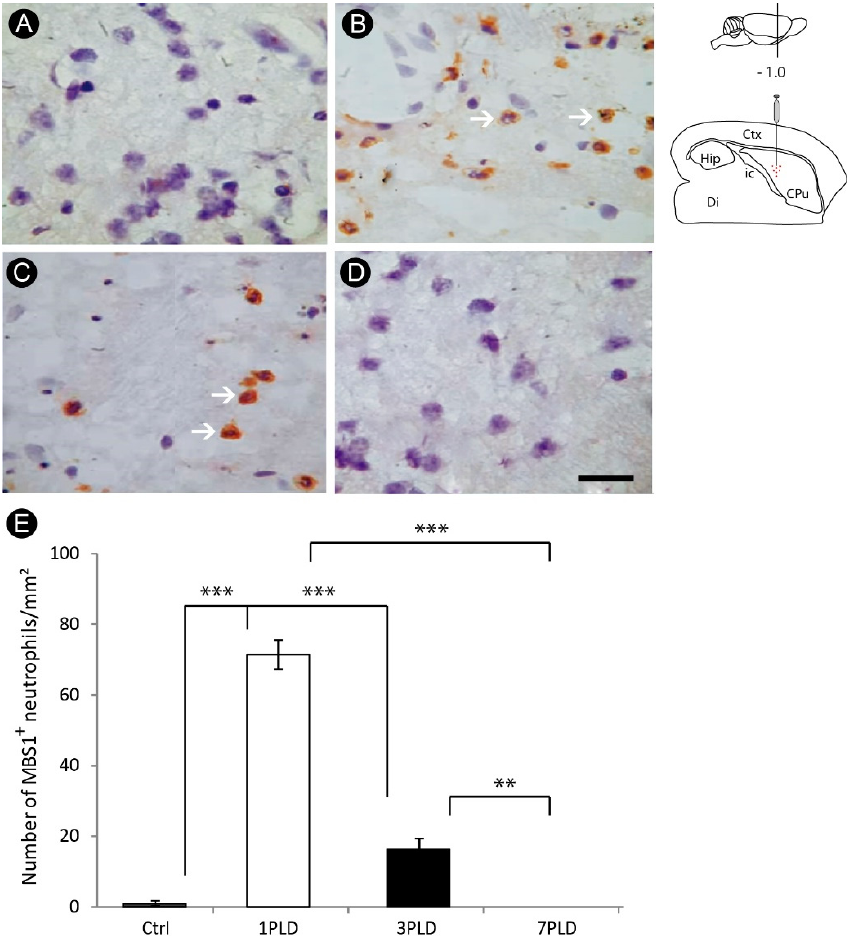
Figure 3. Neutrophil recruitment in the internal capsule following endothelin-1 (ET-1) injection. While in control group the inflammatory response is negligible ( A ), an intense recruitment of neutrophils is observed one day after injection (1PLD) ( B ), with a significant decrease at 3PLD ( C ). Neutrophil response is absent at 7PLD ( D ), as confirmed by quantitative analysis ( E ) (** p < 0.01; *** p < 0.001, ANOVA, Tukey post hoc test). Values expressed as mean ± SEM. Arrows in A and B point to MBS1 + neutrophils. Drawings at the left side of the figure show the anatomical localization of the ET-1 injection in the striatum. Ctx: cortex; CPu: caudate putamen (striatum); Di: diencephalon; Hip: hippocampus; ic: internal capsule. Scale bar: 50 μ m.